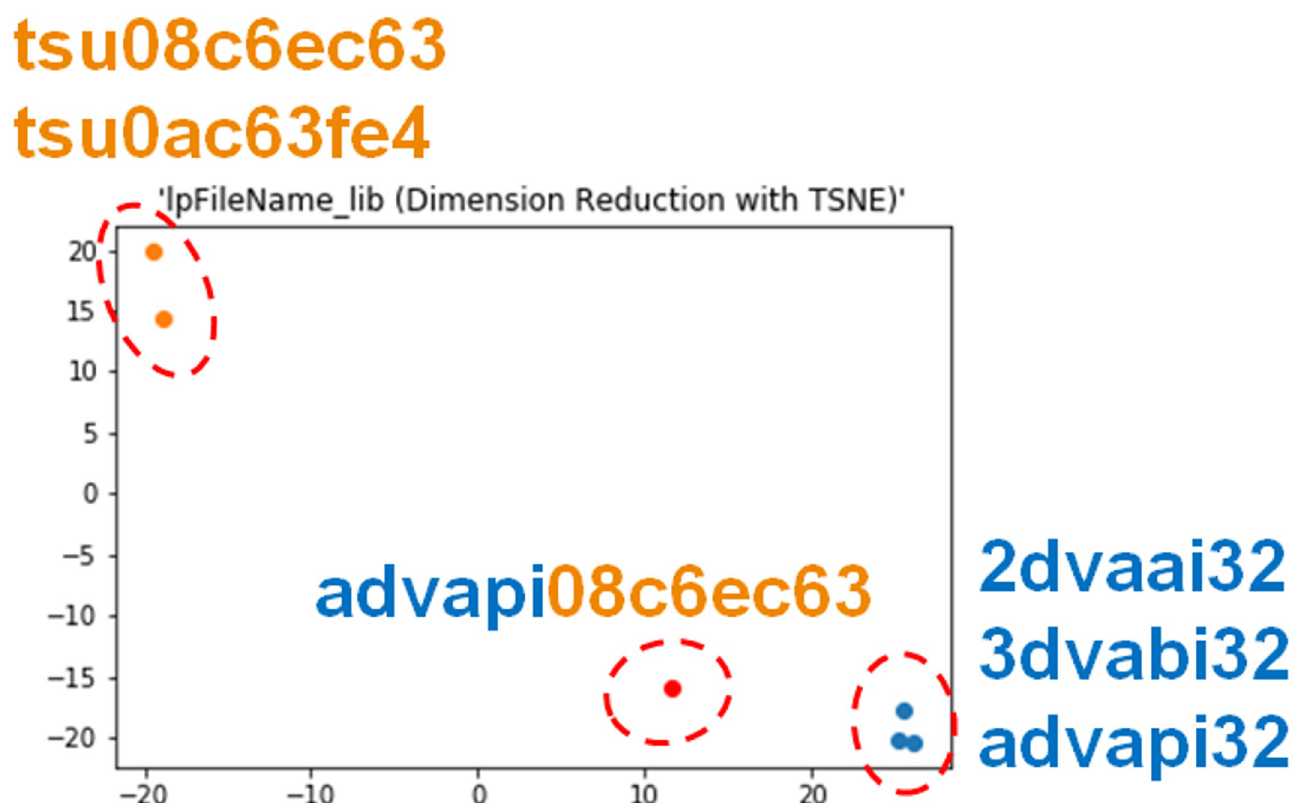
Fig 5. Filename embedding.